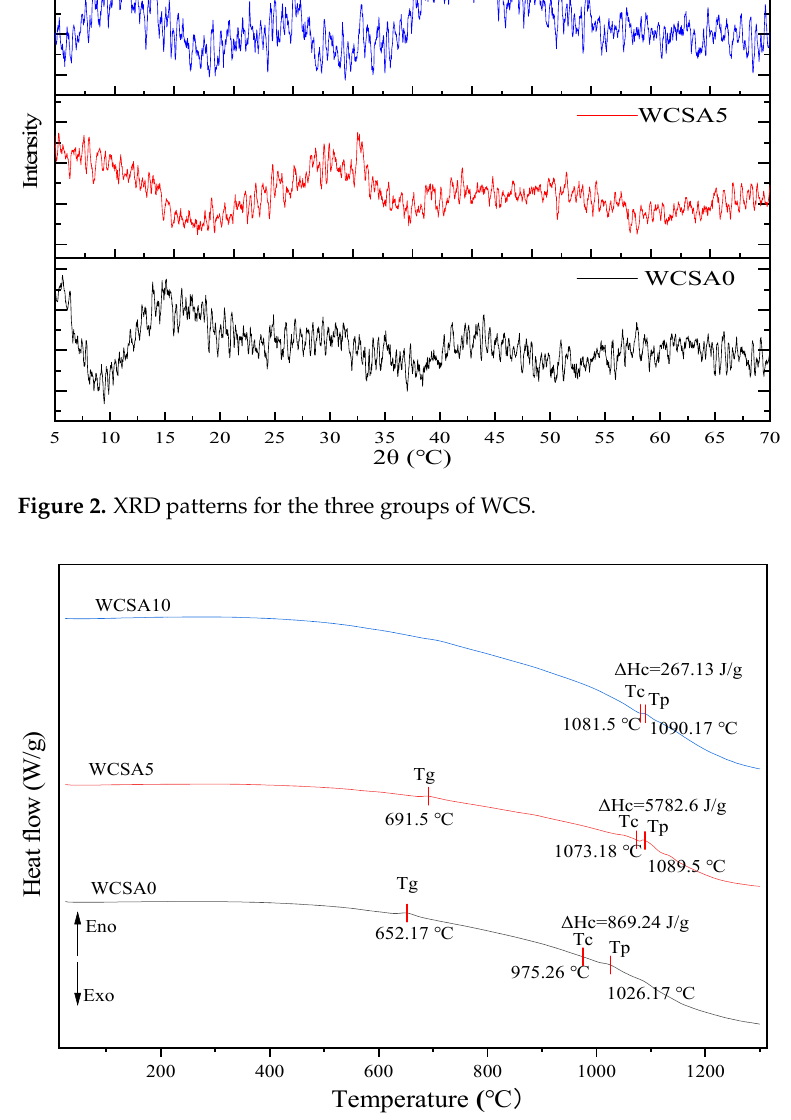
Figure 3. DSC curves for the three groups of WCS.